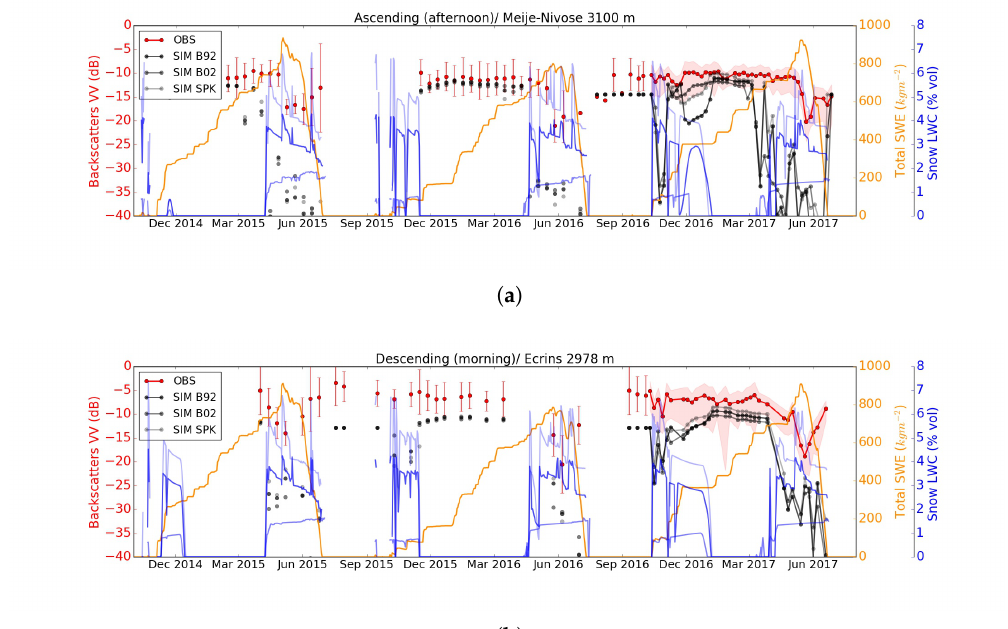
Figure 10. Time series of the observed backscatter values along the three snow seasons and for the simulated backscatter values using the three different schemes of the percolation of liquid water in the snowpack implemented in Crocus for two point-scale simulations. The maximum snow LWC across Crocus snow layers (blue) and the SWE (orange) at the simulation locations are also displayed. ( a ) Ascending orbit/Meije-Nivose station. ( b ) Descending orbit/Ecrins station. Error bars and shading represent one standard deviation around the mean of the observation values, shading being used when the time between two consecutive observations is less than six days.